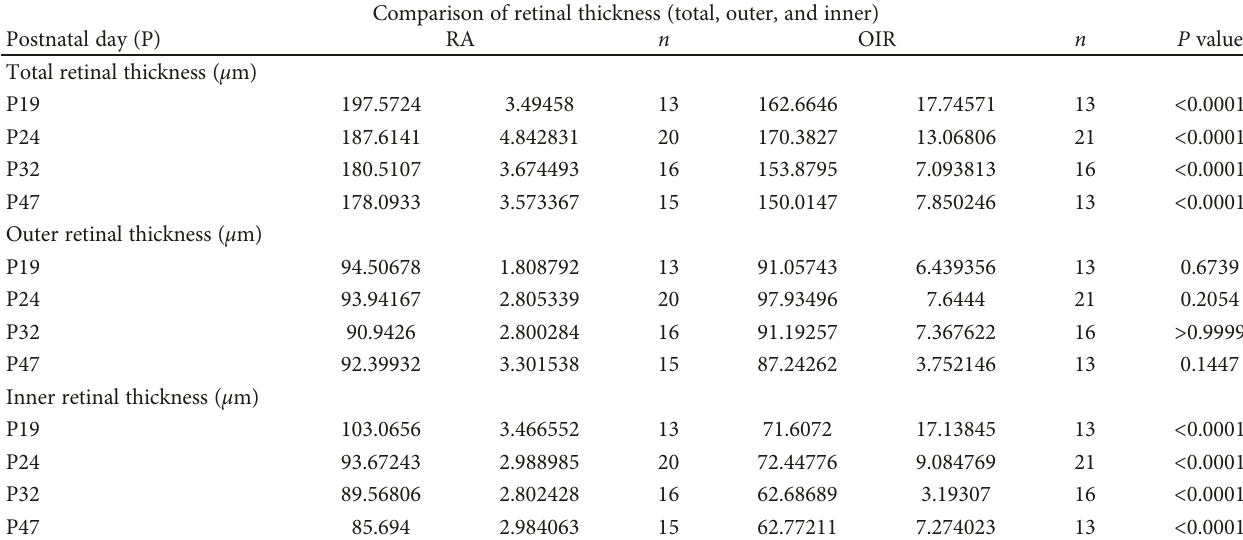
Table 1: Comparison of retinal thickness at di ff erent postnatal day ages. Comparison of retinal thickness (total, outer, and